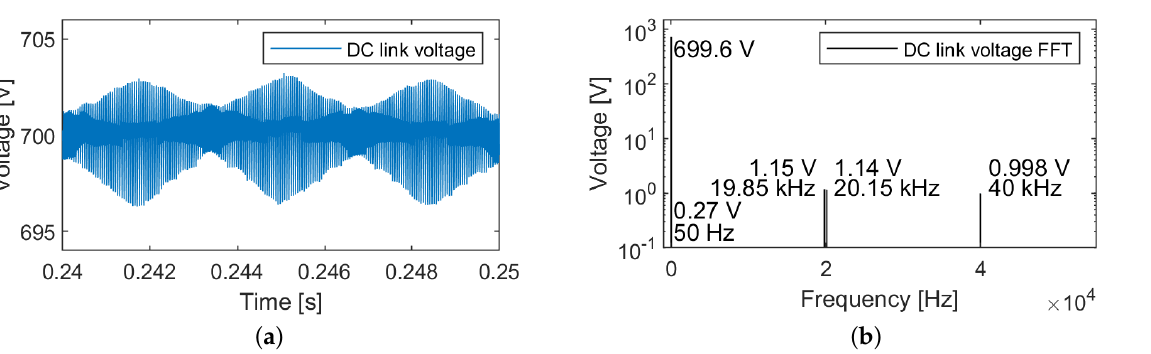
Figure 10. Two-level six-switch boost-type rectifier simulation results. ( a ) DC link voltage. ( b ) DC link voltage harmonic